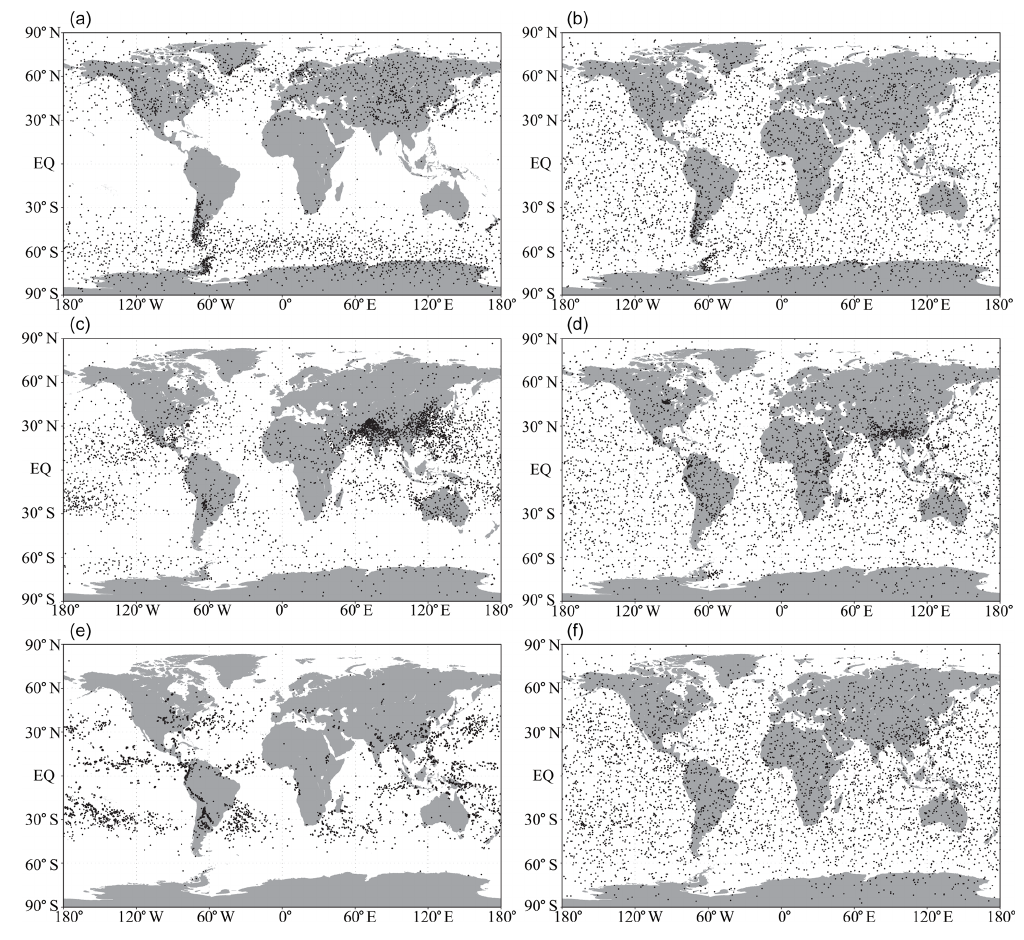
Figure 7. Locations of selected profiles in the temperature (a, b) , specific humidity (c, d) and cloud condensate (e, f) sampled from subsets of the IFS-91 (a, c, e) and IFS-137 (b, d, f) databases (from https://www.nwpsaf.eu/site/update-137-level-nwp-profile-dataset/, last access: